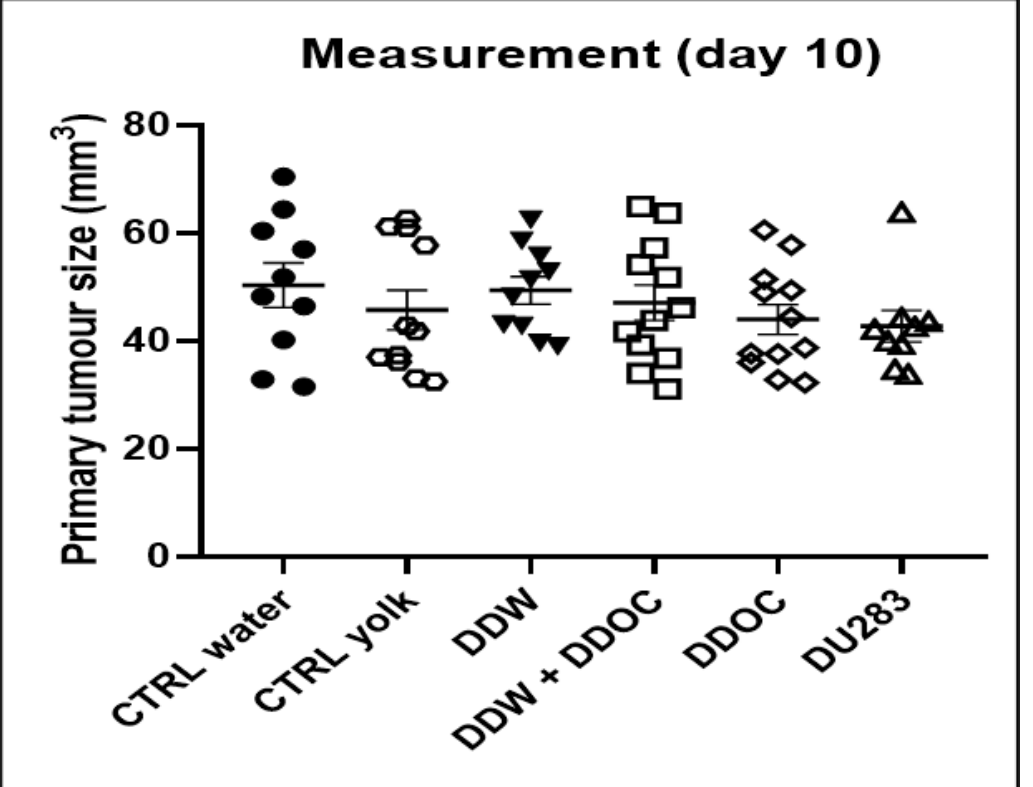
Figure 2. Tumor volume 10 days after inoculation of 4T1 cells (100,000/animal in 50 µL) into the mice’s mammary pad. Dots represent individual data while the horizontal line with error bar shows mean and SD.